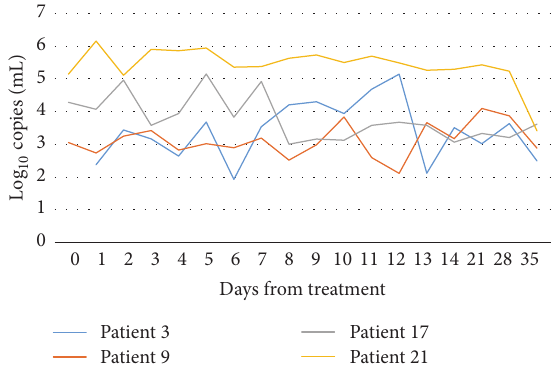
Figure 2: Bacterial load in participants infected with an A2058G mutation. All samples stayed positive throughout the whole test